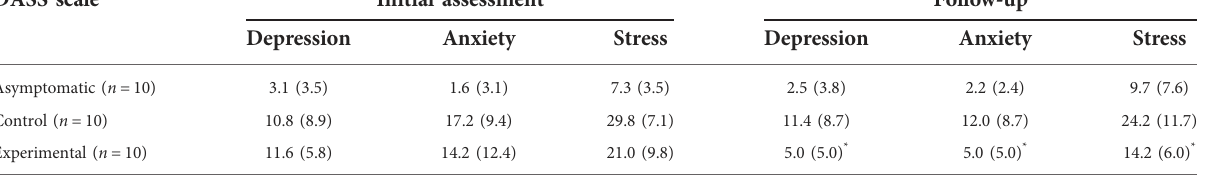
*Indicates signi fi cant differences within groups at p ≤